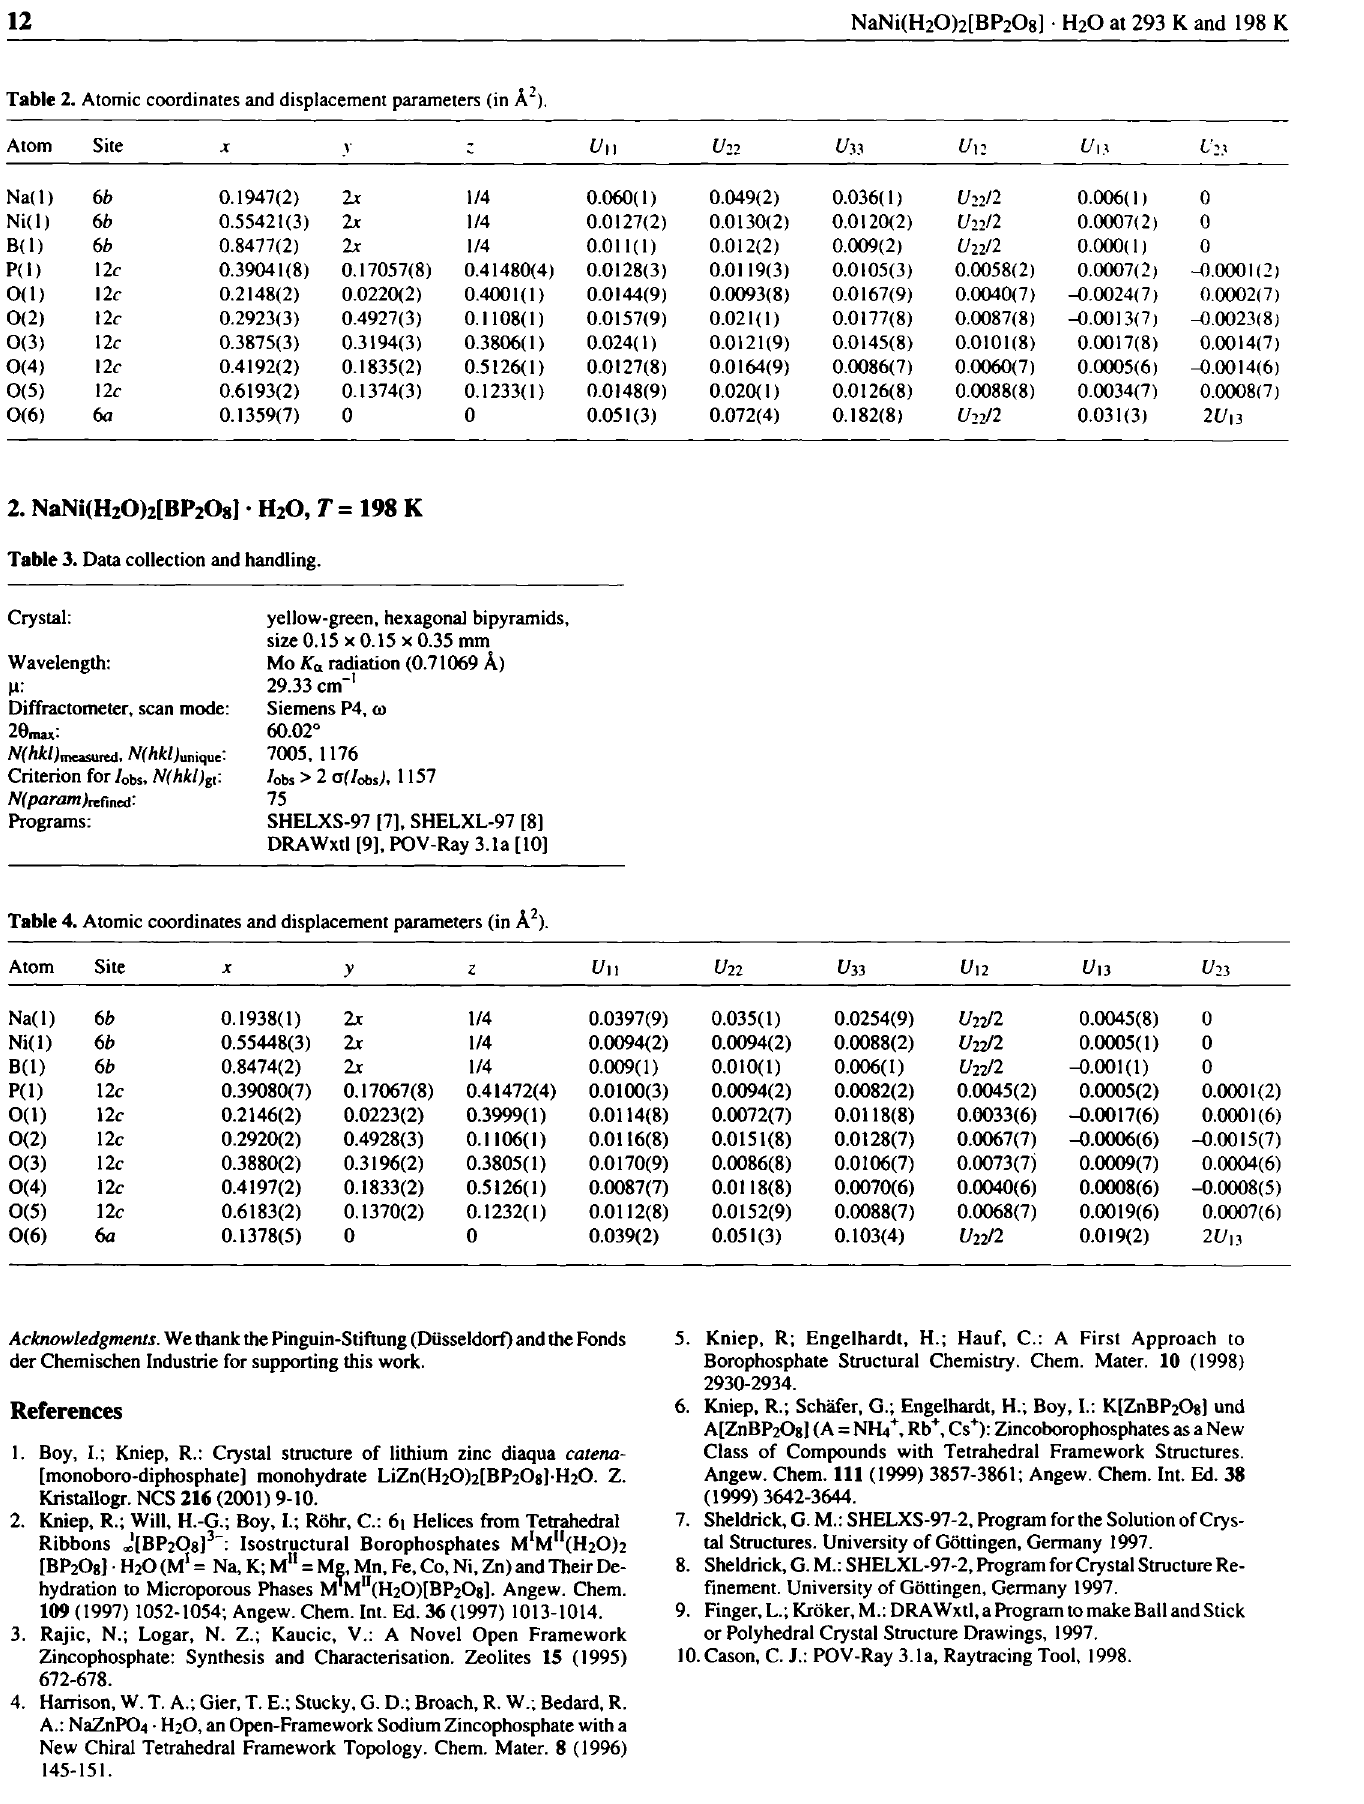
Table 2. Atomic coordinates and displacement parameters (in A 2 ).